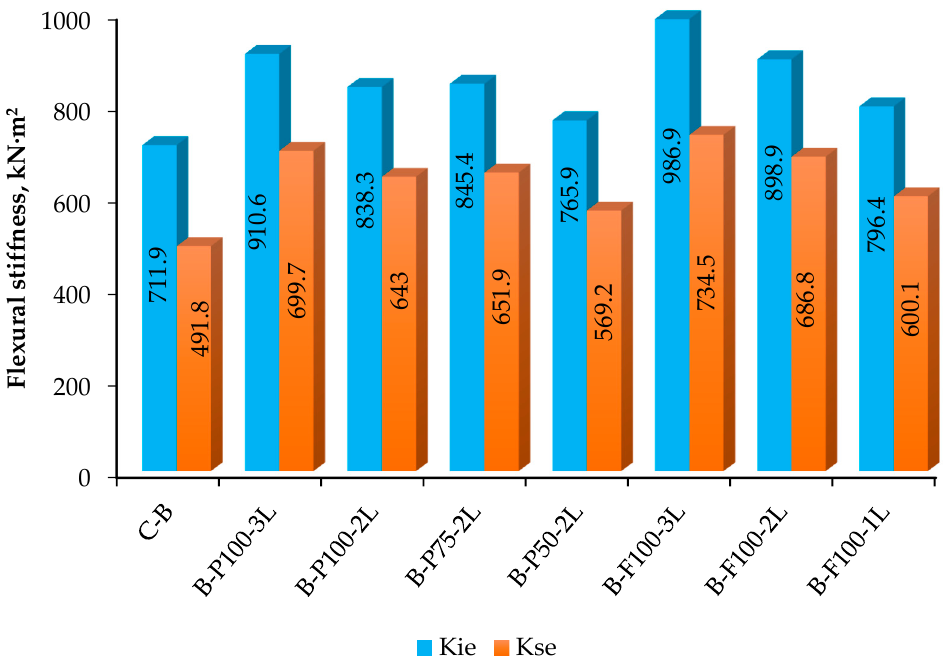
Figure 13. Flexural sti ff ness (K ie and K se ) of HPCFDST specimens.